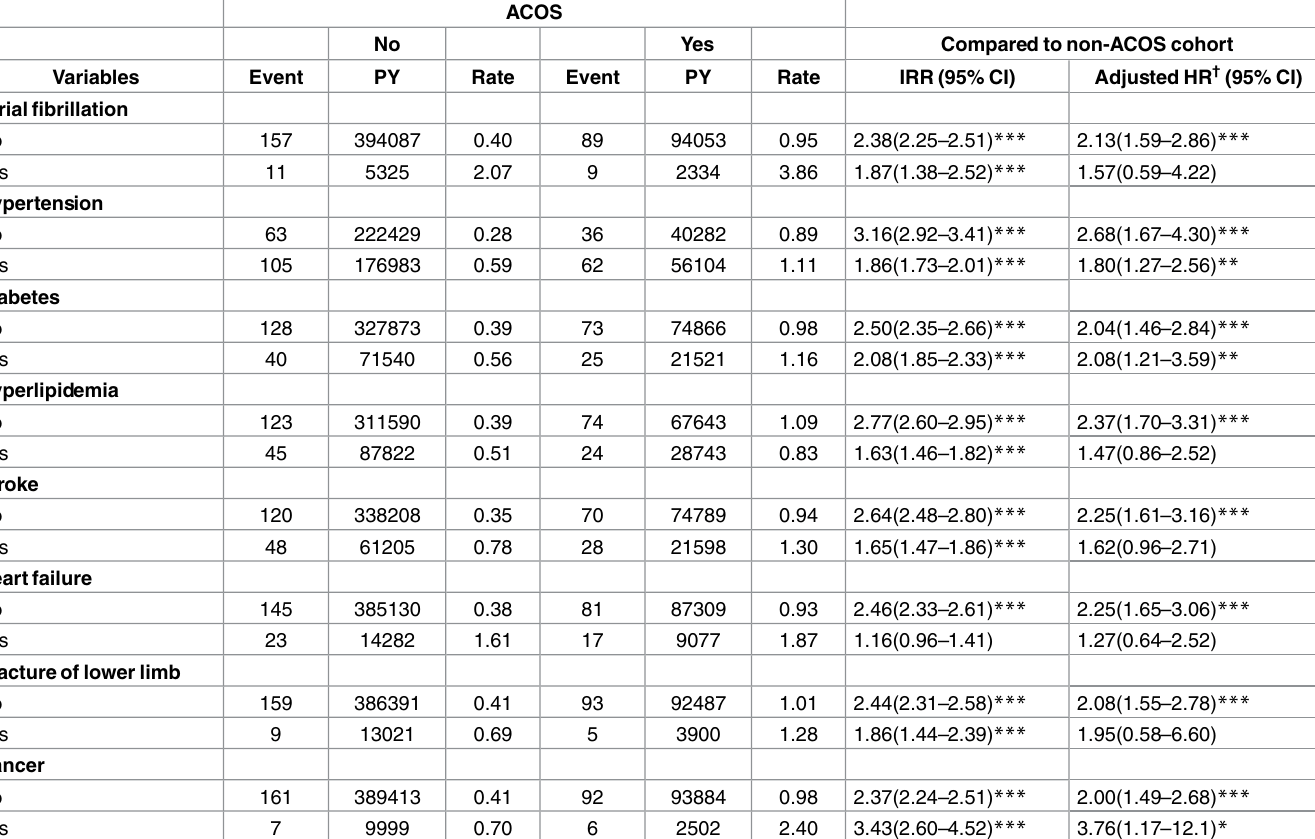
Table 3. Incidencerate and adjusted hazard ratioof pulmonary embolismbetweenACOS and non-ACOS cohorts stratified by each comorbidity